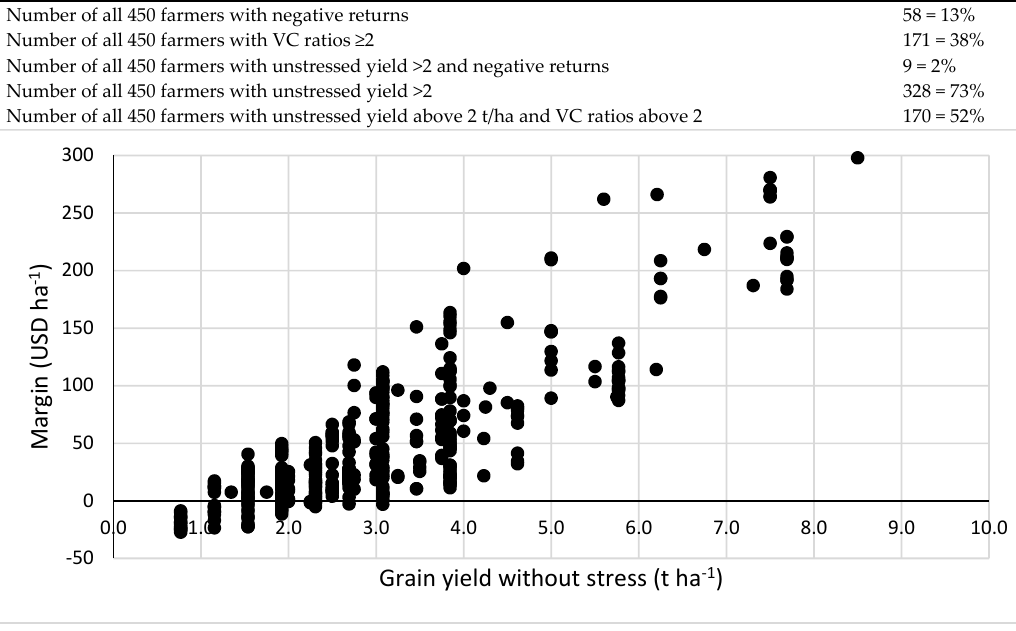
Figure 5. Relation between maize grain yield without stress and the estimated margin of all participating farmers using the insect resistant genetically modified Bt hybrid maize. Economic performance indicators including the value/cost (VC) ratio are given above the figure.